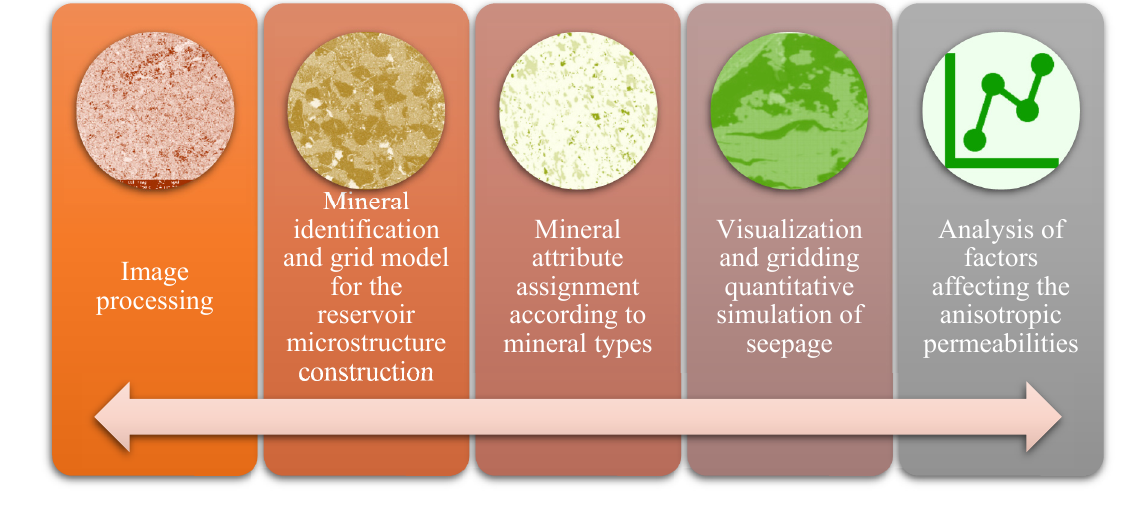
Figure 2. The technical workflow used.